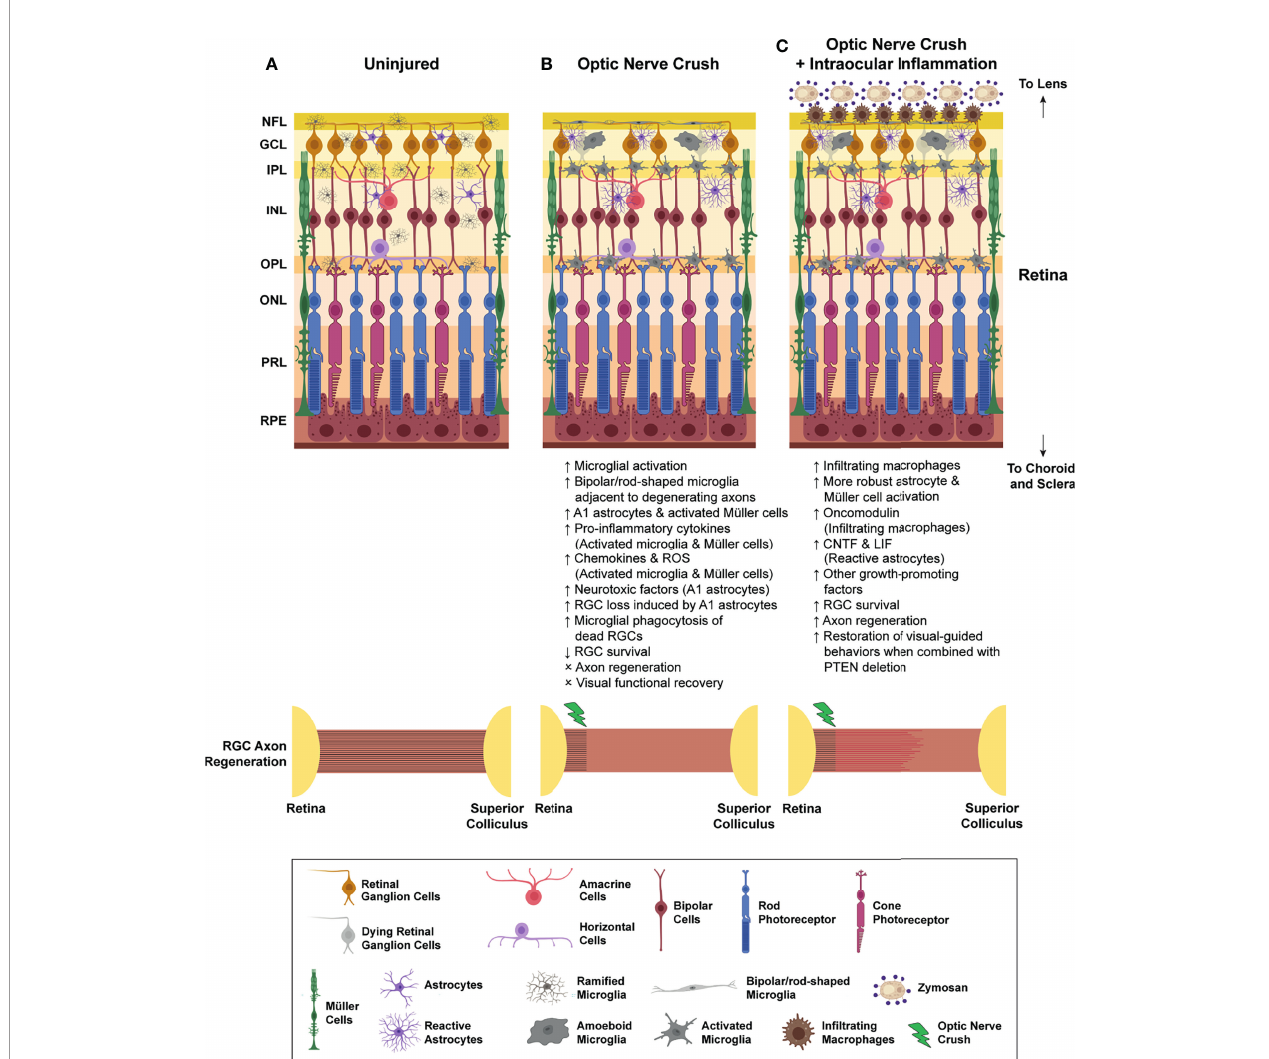
FIGURE 1 | In fl ammatory responses after optic nerve crush (ONC) injury. (A) In the intact retina, retinal microglia usually resided in NFL, GCL, IPL, INL, and OPL. These resident retinal microglia adopt rami fi ed morphology with which they constantly send and withdraw their processes to sense the surrounding microenvironment. Retinal astrocytes and Müller cells are the two major macroglial cells that resided in retinae for the maintenance of retinal homeostasis. (B) Optic nerve crush (ONC) triggers the activation of resident retinal microglia, as well as retinal astrocytes and Müller cells. Some of the microglia transform into bipolar/rod- shaped microglia and colonize adjacent to the degenerating RGC axons in NFL. These bipolar/rod-shaped microglia actively internalized these degenerating axons after ONC. Some activated microglia adopt amoeboid morphology and actively engulf the dead RGCs in GCL. Also, these activated retinal microglia produce a broad spectrum of pro-in fl ammatory cytokines (e.g. IL-1 b , IL-6 and TNF- a ), chemokines (CCL2, CCL3 and CCL5), and reactive oxygen species (ROS), which induced reactive astrocytes to adopt a neurotoxic A1 phenotype and increased production of neurotoxic factors. Activated Müller cells are also responsible for the production of pro-in fl ammatory cytokines in the injured retinae. Collectively, the number of survived RGCs gradually declined over time, and most of these survived RGCs failed to regenerate across the lesion site, leading to a permanent vision loss after ONC. (C) Intraocular in fl ammation induced by zymosan or curdlan treatment, or lens injury triggers a massive in fl ux of blood-borne myeloid cells, and robust astrocyte and Müller cell activation. The in fi ltrating myeloid cells produce a large quantity of growth-promoting factors, such as oncomodulin, which promoted RGC survival after ONC. The reactive astrocytes also elevate the production of CNTF and LIF after intraocular in fl ammation. More importantly, the macrophage- and astrocyte-derived growth-promoting factors stimulate robust axon regeneration which enabled a partial restoration of some visual-guided behaviors when combined with other manipulations, such as PTEN deletion. NFL, nerve fi bre layer; GCL, ganglion cell layer; IPL, inner plexiform layer; INL, inner nuclear layer; OPL, outer plexiform layer; ONL, outer nuclear layer; PRL, photoreceptor layer; RPE, retinal pigment epithelium; RGC, retinal ganglion cell; ROS, reactive oxygen species. CNTF, ciliary neurotrophic factor; LIF, leukemia inhibitory